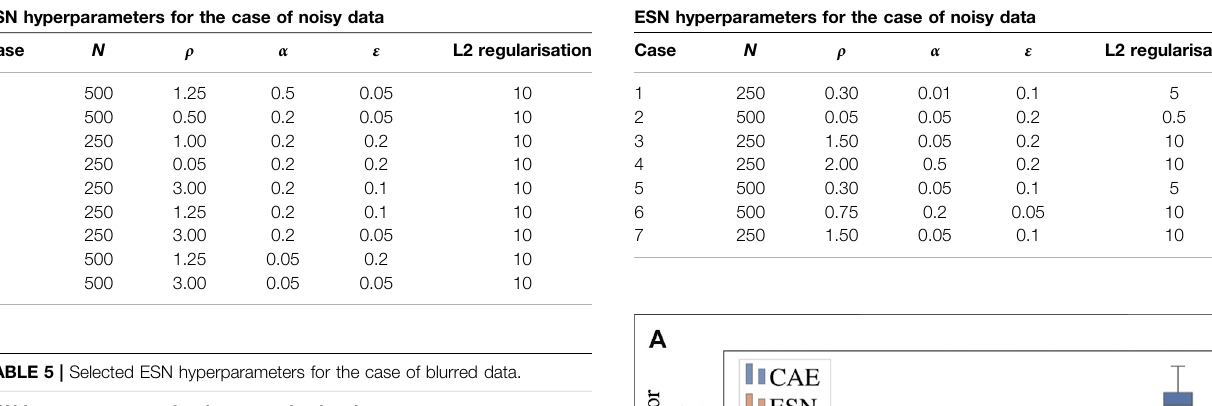
TABLE 6 | Selected ESN hyperparameters for the case of undersampled data.